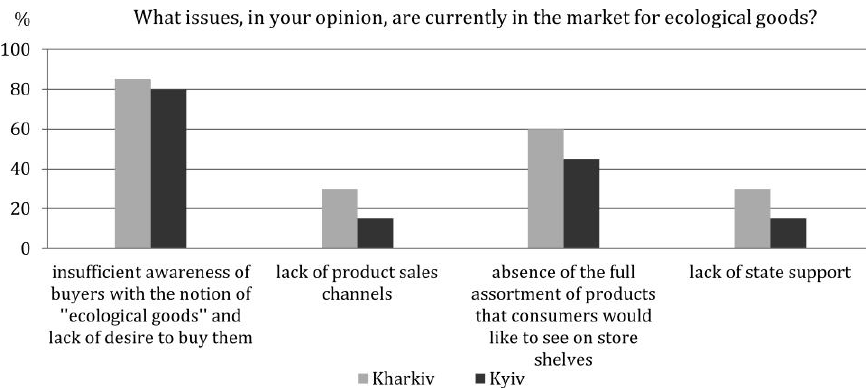
Fig. 12. The problems that are inherent in the market of ecological goods (Source: author's